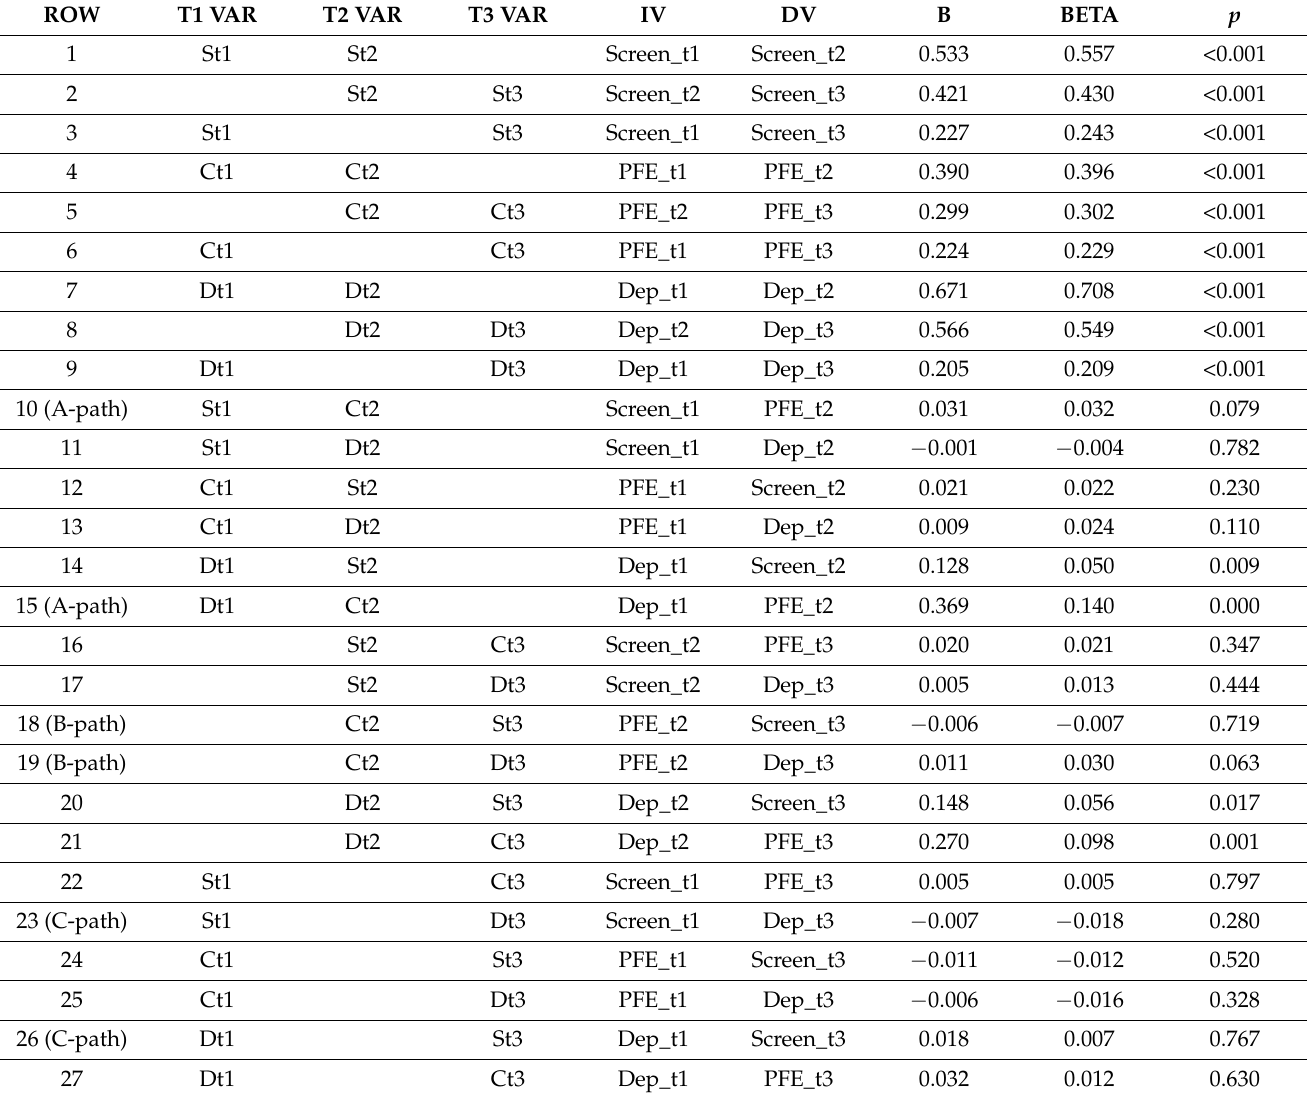
Table A3. Model estimates from the structural regression (post hoc pathway) analysis: prediction estimates. Rows 10 and 15 are A-paths; rows 18 and 19 are B-paths; rows 23 and 26 are